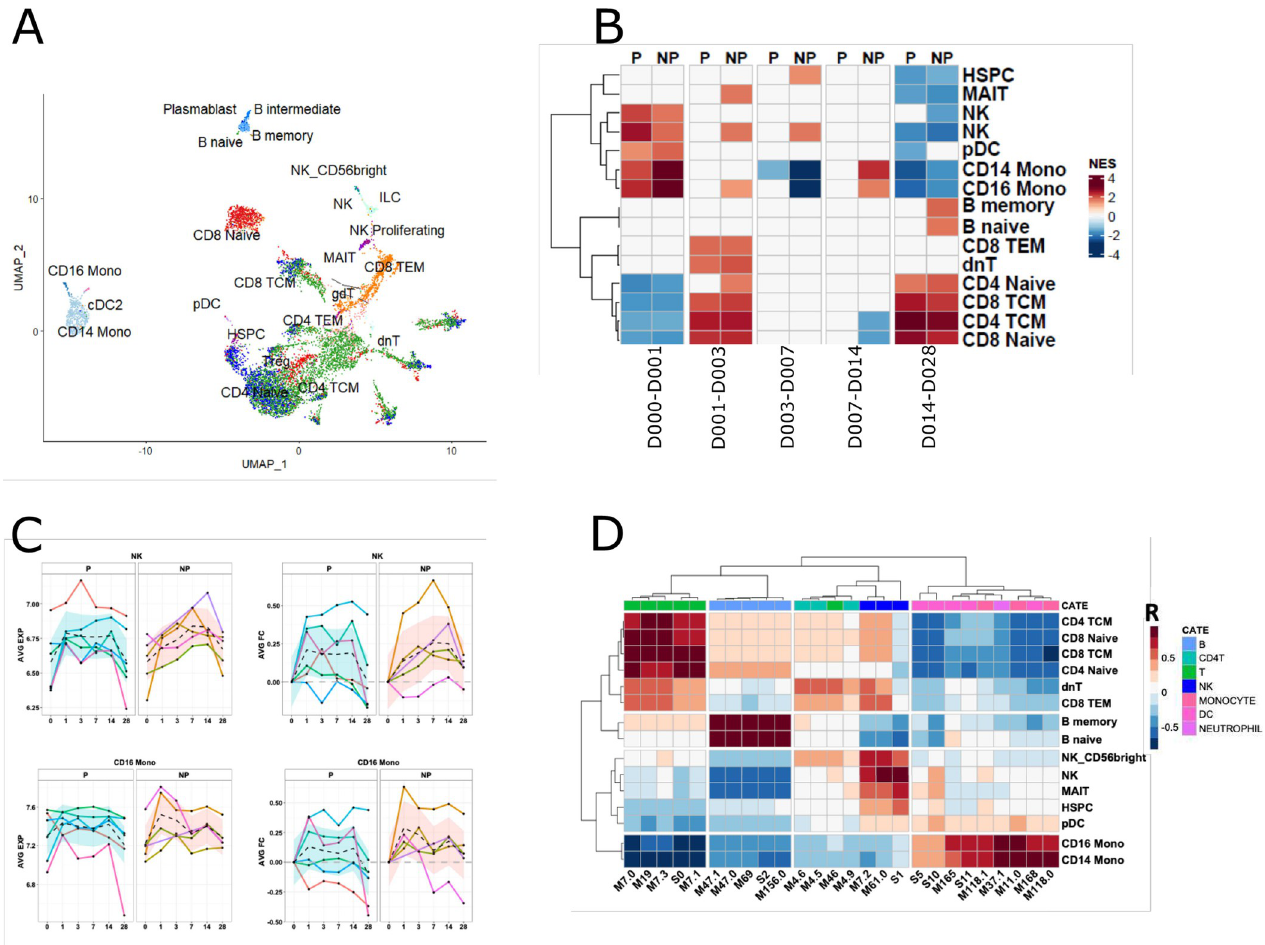
Fig 7. Validation of transcriptional changes of specific cell types using CITEseq data. A. Scatter plot illustrating cell types identified in CITEseq data, visualized using uniform manifold approximation and projection (UMAP). Each point represents a cell and is colored by cell type. B. Heatmap showing GSEA NES of CITEseq-derived cell signatures in whole-blood RNAseq in response to the first immunization in P and NP subjects. C. Lineplot showing kinetics of CITEseq-identified cell signatures in P and NP subjects. Each line represents the median gene expression levels of a CITEseq gene signature per-subject, and the black dashed line represents the median gene expression levels across all in P or NP subjects. D . Heatmap showing Spearman’s rank correlation between cell-type specific BTMs and CITEseq identified cell-specific signatures. The color row bar indicates cell-type annotation of BTMs.